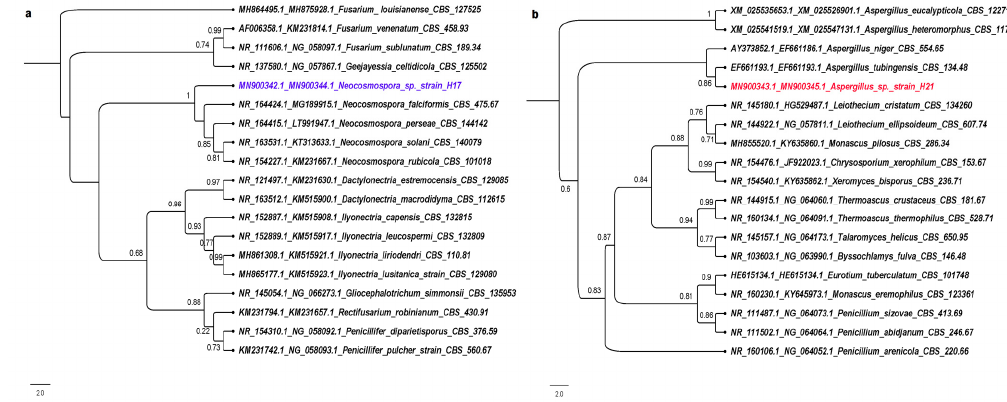
Figure 2. Phylogenetic reconstruction of the concatenated ITS1-ITS2–D1-D2 sequences for strain H17 ( a ) and H21 ( b ). Only sequences from type specimens and confirmed in publication were used for the phylogeny reconstruction. Accession numbers for ITS and D1-D2 regions (in this order) are shown for each specimen considered in the phylogeny.